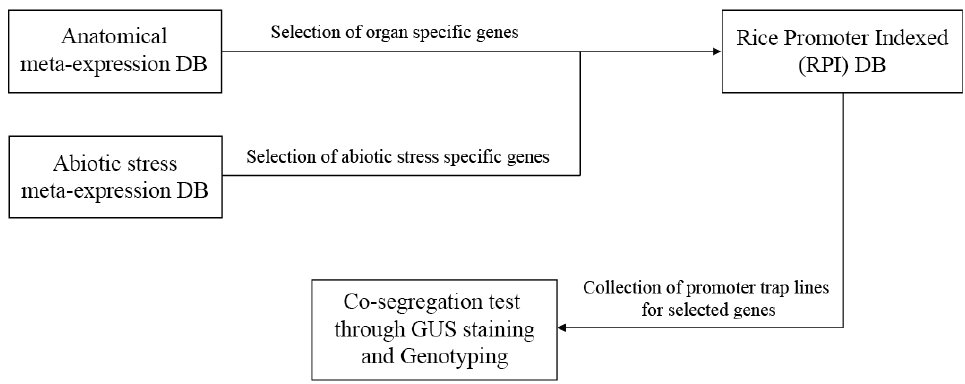
Figure 1. Workflow diagram summarizing the analysis process of the promoter trap line. DB: database.